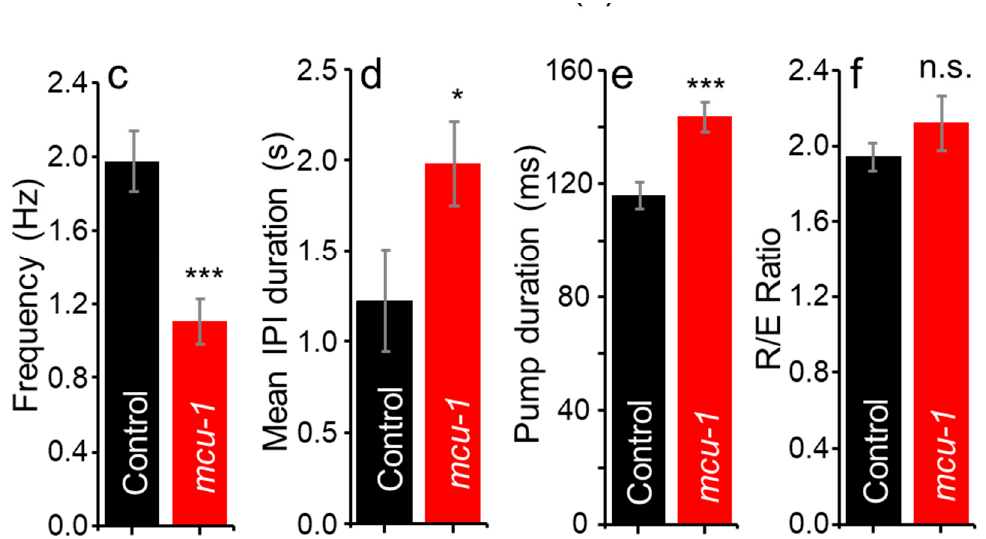
Figure 2. Electropharyngeograms (EPGs) obtained in N2 and mcu-1 mutants. Panels ( a , b ) show typical EPGs obtained either in control N2 worms or in mcu-1 mutants, respectively. Panel ( c – f ) shows the mean values of several parameters obtained from 3-min EPG records of 52 control N2 worms and 77 mcu-1 mutants. The meaning of the parameters is shown in panels ( a , b ) waves E (depolarization) and R (repolarization), pump duration and interpump interval (IPI). ***, p < 0.001; *, p < 0.05, ANOVA test.